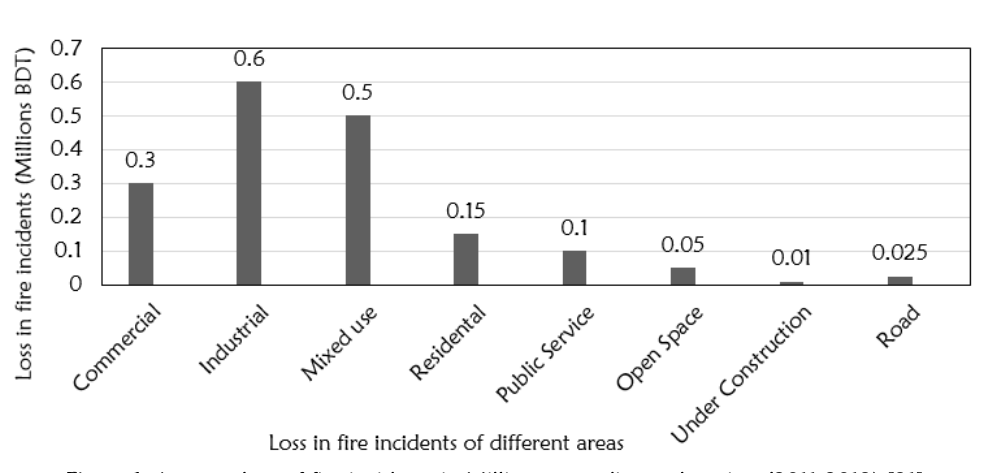
Figure 1: Average loss of fire incidents in Millions according to location (2011-2013) [31].